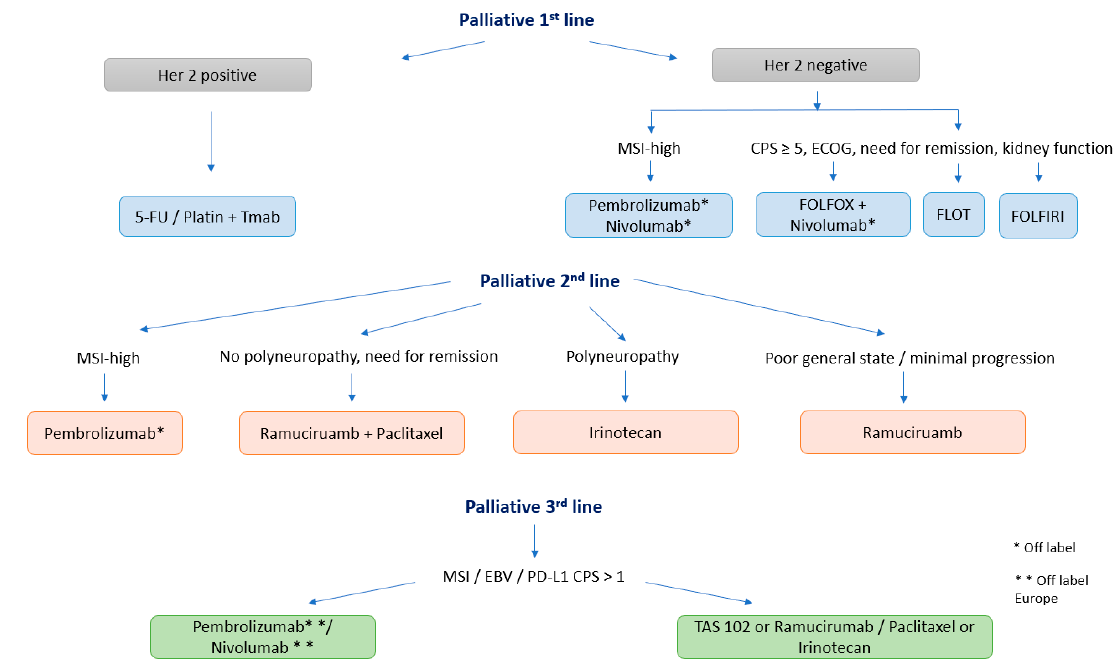
Figure 4. Overview of a possible algorithm for palliative therapy regimes in gastric cancer .